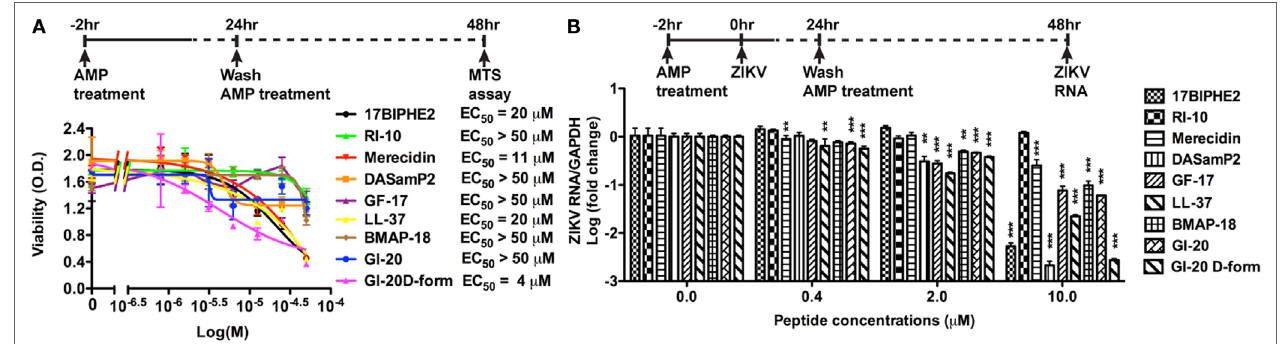
FigUre 2 | Antimicrobial peptides derived from cathelicidins inhibit Zika virus (ZIKV) infection in Vero cells. (a) Vero cells were treated with doses of peptides ranging from 1 to 50 µM. After 24 h, the cultures were washed and treated with same doses of peptides in fresh medium for another 24 h. Cell viability was determined by a colorimetric MTS assay. Results shown are the averages ± SD of experiments performed in triplicate. Data were analyzed by non-linear regression. The EC50 was assessed for each of the antimicrobial peptides. (B) Vero cells were treated with doses of peptides ranging from 0.4 to 10 µM for 2 h then infected with ZIKV at the MOI of 0.5. After 24 h, the cultures were washed and treated with same doses of peptides in fresh medium for another 24 h. ZIKA RNA was detected in total cellular RNA through real-time RT-PCR. Data were normalized to GAPDH and presented as fold change (in log scale) compared with ZIKV group. ** p < 0.01 and *** p < 0.001, as compared with the ZIKV group without the peptide treatment (ANOVA, N =